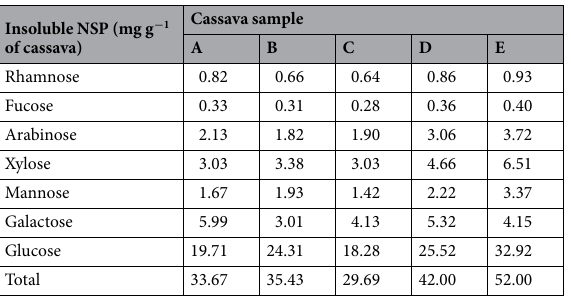
Insoluble NSP (mg g − 1 of cassava)